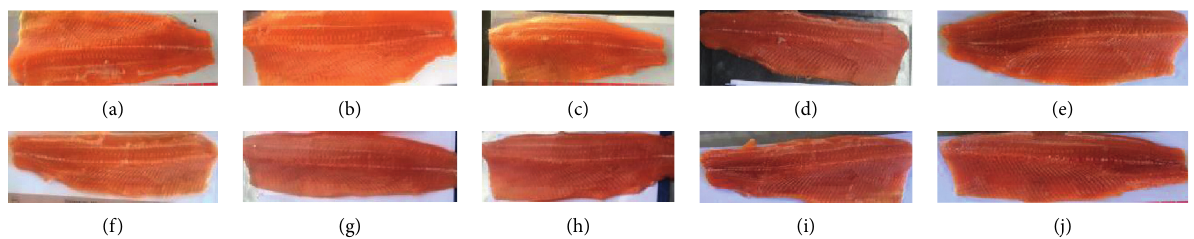
Figure 6: Muscle coloration of flesh at the end of experiments: (a) diet I; (b) diet II; (c) diet III; (d) diet IV; (e) diet V; (f) diet VI; (g) diet VII; (h) diet VIII; (i) diet IX; (j) diet X.